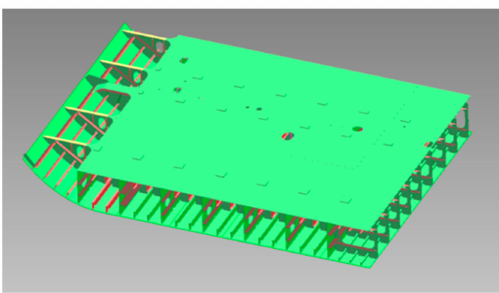
Figure 9. Block stereogram.